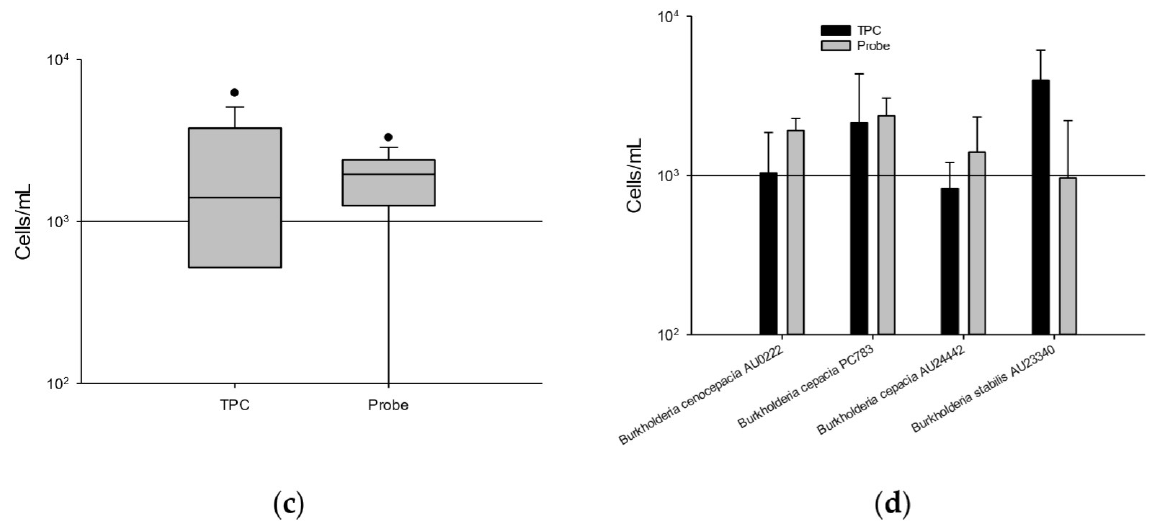
Figure 4. Bacterial abundance assessed for 10 CFU/mL by the TPC and Kef probe assays using flow cytometry in CHX ( a , b ) and BZK ( c , d ). There were no significant differences between probe and TPC ( a : p = 0.329, c : p = 0.981). Statistical analysis was performed via a paired t-test using SigmaPlot vs. 13.0 software.